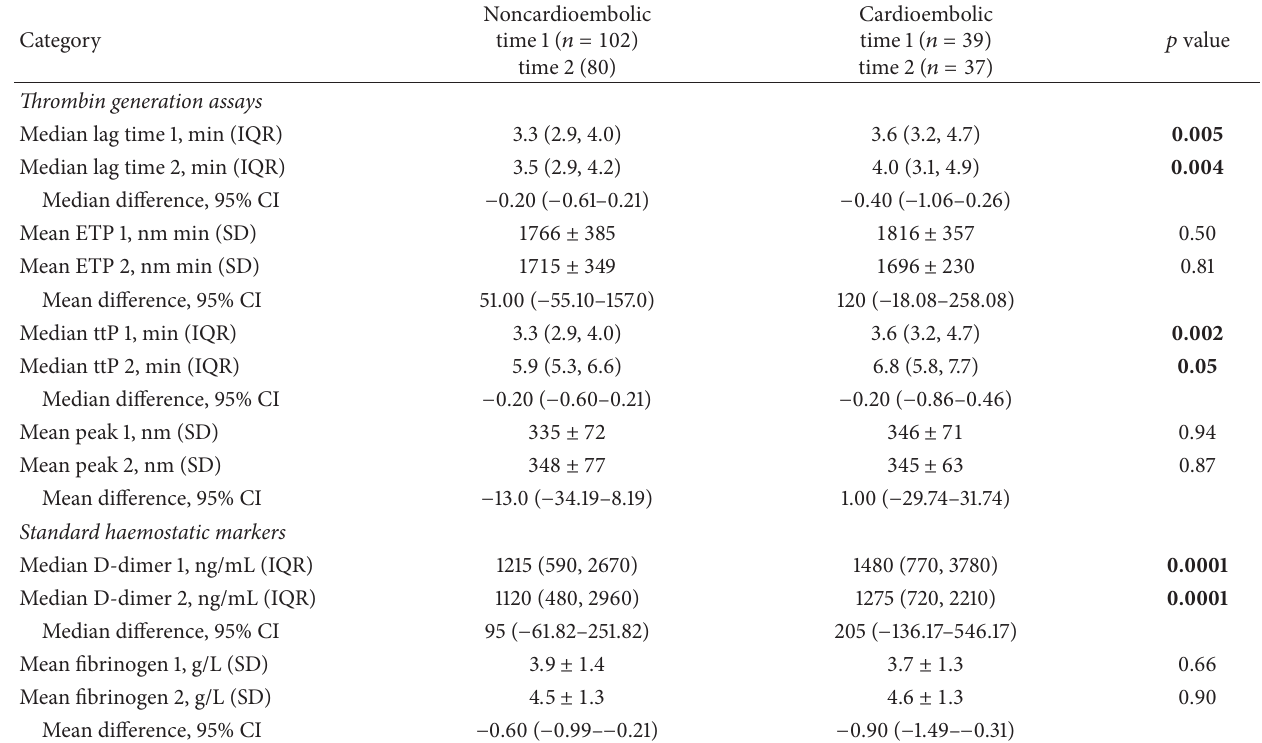
Table 3: Thrombin generation in ischaemic stroke